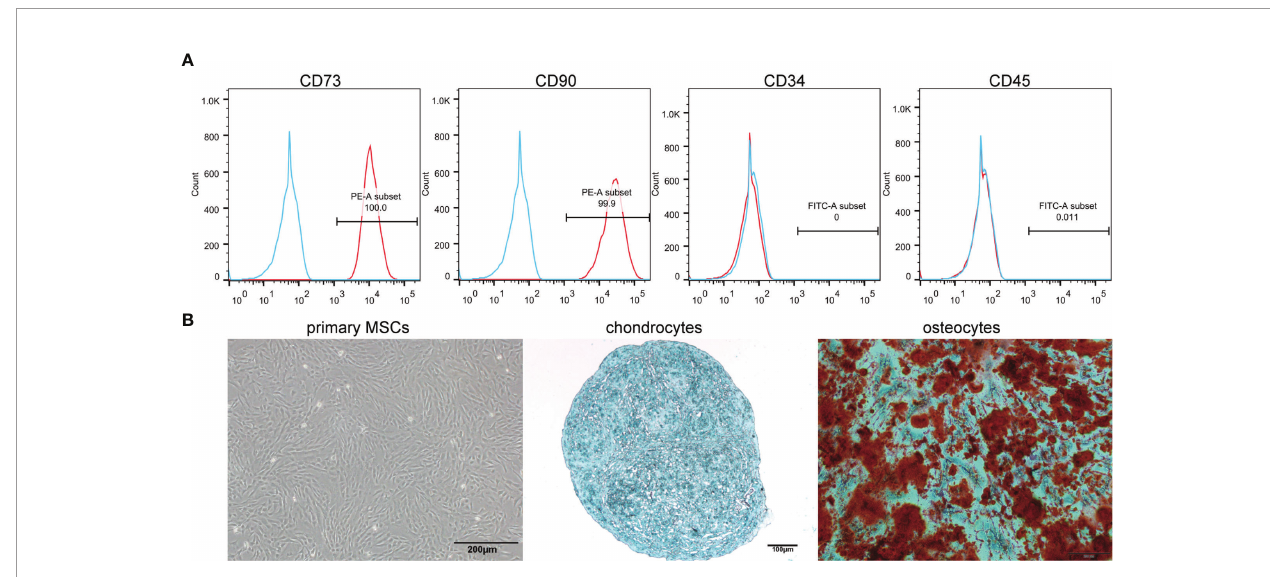
FIGURE 1 | Identi fi cation of MSCs. (A) Immunophenotypic characterization of hMSCs was performed by fl ow cytometry. The vast majority of cells (>99%) were positive for CD73 and CD90, but a few cells (<0.1%) expressed CD34 and CD45. (B) Primary cells presented as morphologically homogeneous, with elongated spindle appearance. The hMSCs were cultured in appropriate differentiation media for 3 weeks. For chondrogenic differentiation, the fi xed chondrospheres were embedded and cut into sections and stained with alcian blue. The induced cells were stained by oil red O to indicate